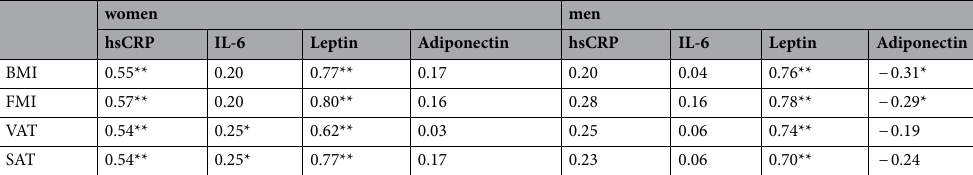
Table 3. Correlation coefficients between BMI or fat compartments and inflammation markers, leptin or adiponectin in the subgroups of men and women. hsCRP , high-sensitivity C-reactive protein; IL-6 , interleukin